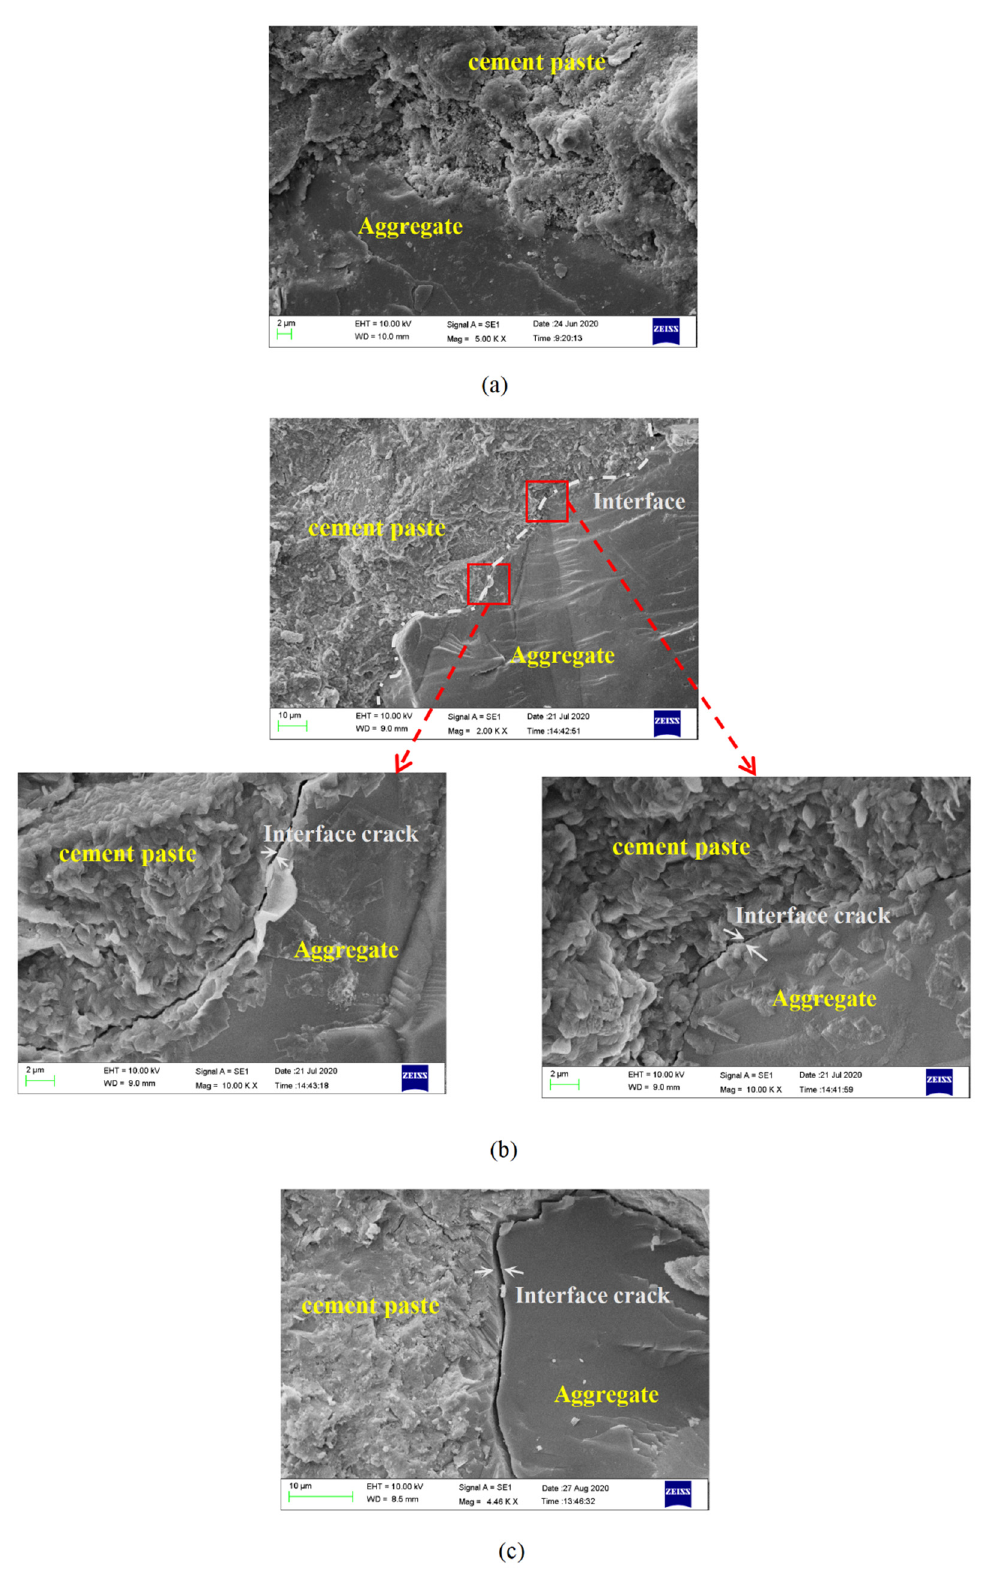
Figure 16. SEM image of aggregate interface with different freeze-thaw cycles ( a ) Initial; ( b ) F-T 50 times; ( c ) F-T100